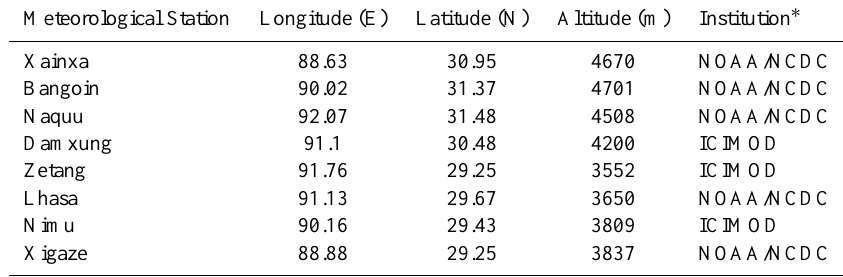
Table 1. Meteorological stations surrounding Nam Co basin.